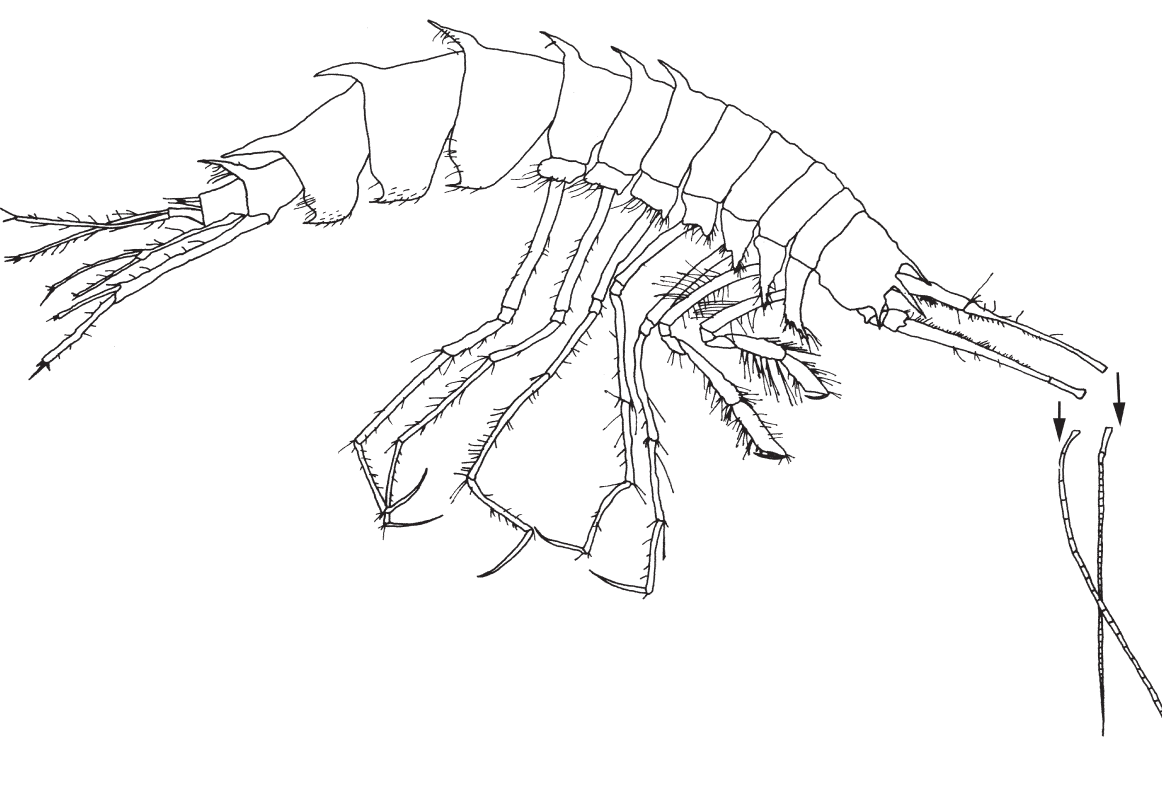
Fig . 7. – Lepechinella laurensi n. sp., holotype, male, 5.7 mm, MnrJ16485, oceanprof ii #58, 21°57’26.8”S,